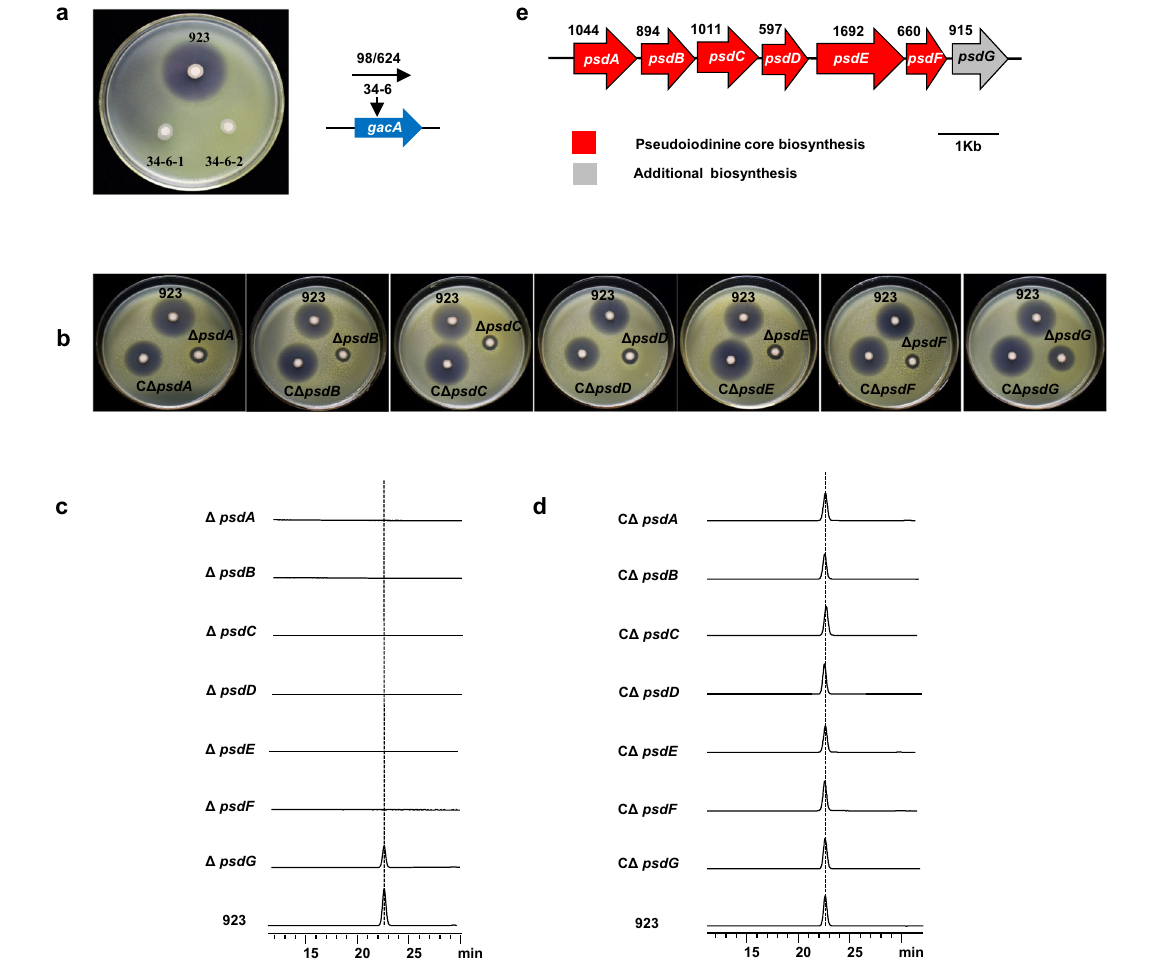
923. Numbers above the gene names indicate the ORF length. Colors denote gene functions asfollows: red,primarybiosyntheticgenes;gray, additionalbiosynthetic genes. The seven gene annotations are displayed as follows: psdA , methyl- transferase type 12; psdB , glyoxylase bleomycin resistance protein dioxygenase superfamily protein; psdC , sulphatase-modifying factor protein; psdD , GTP cyclo- hydrolase; psdE , WD-40 repeat protein; psdF , methyltransferase domain; psdG , ribo fl avin biosynthesis protein